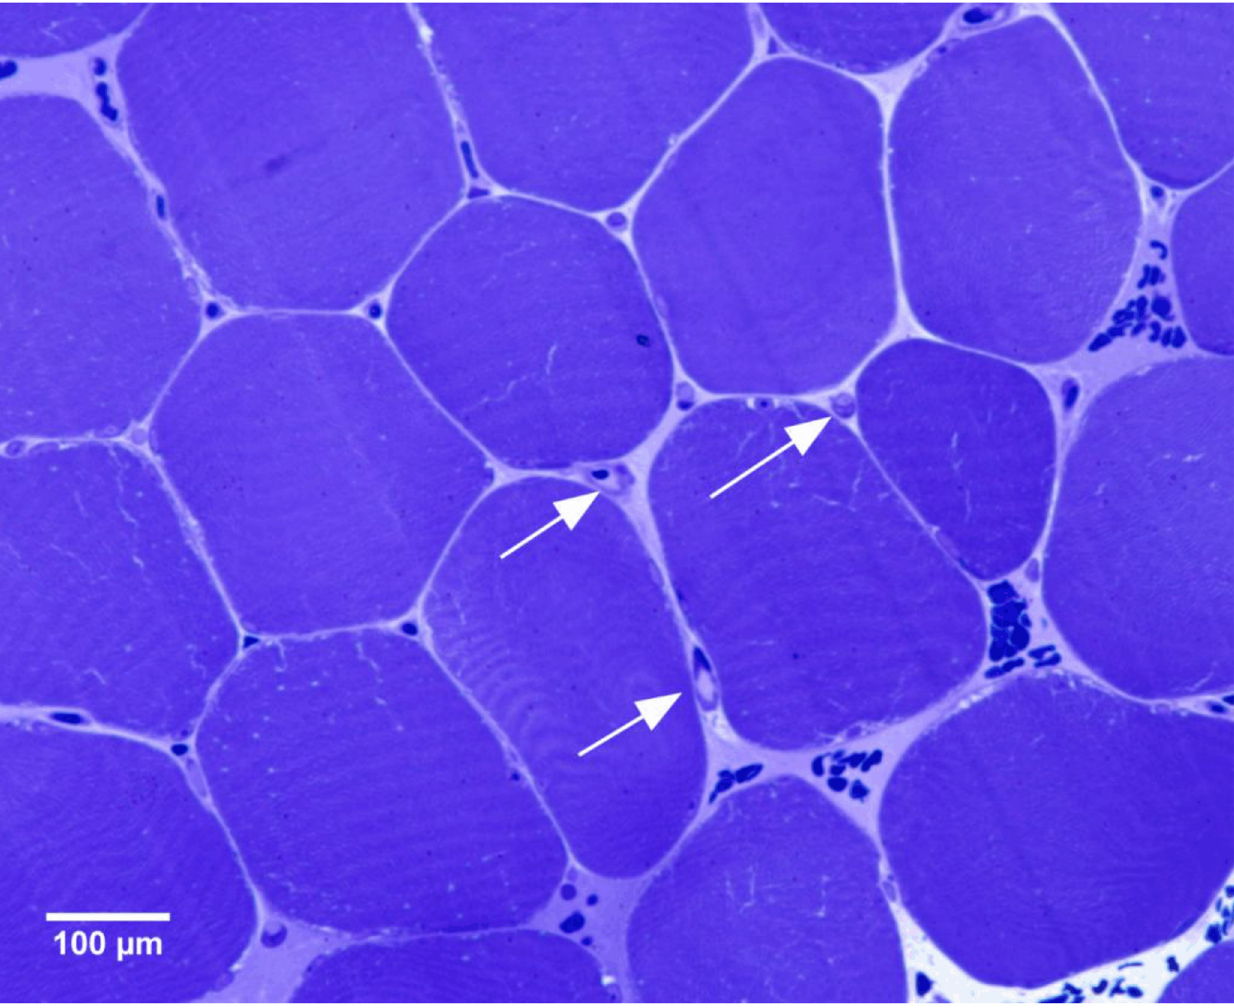
Fig 1. Transverse section of human muscle fibers, preserved in epoxy resin. A representative area of a part of vastus lateralis muscle stained with the mixture of toluidine and methylene blue is showed. The arrows indicate the cross section of